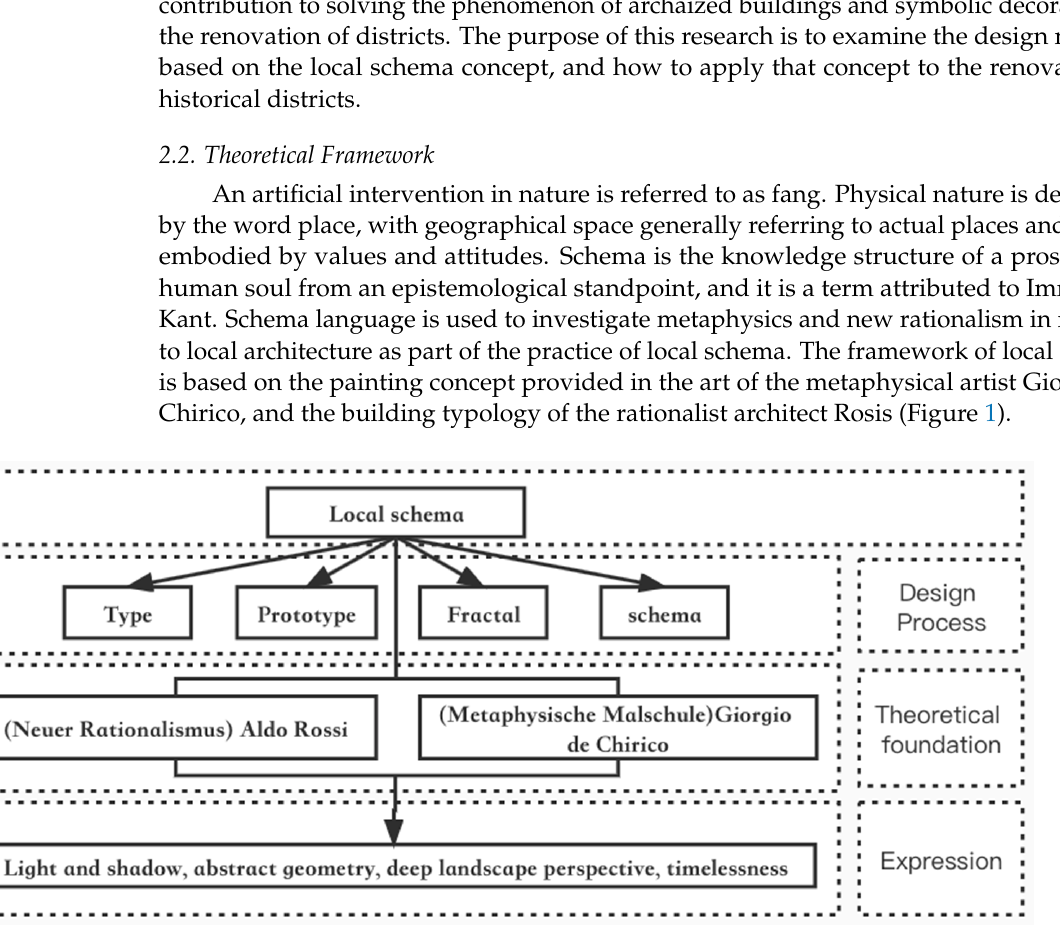
Figure 1. Architecture Foundation of Local Schema.